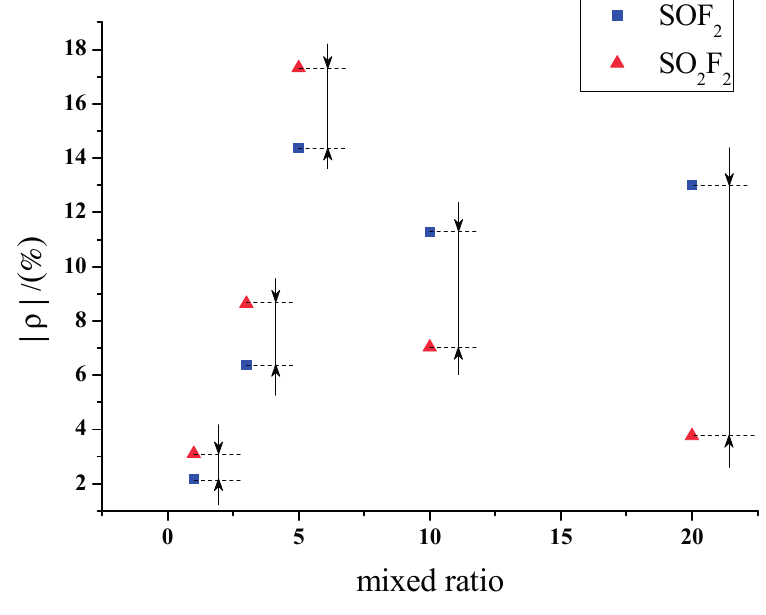
Figure 11. Response of MWNT sensor to SOF 2 and SO 2 F 2